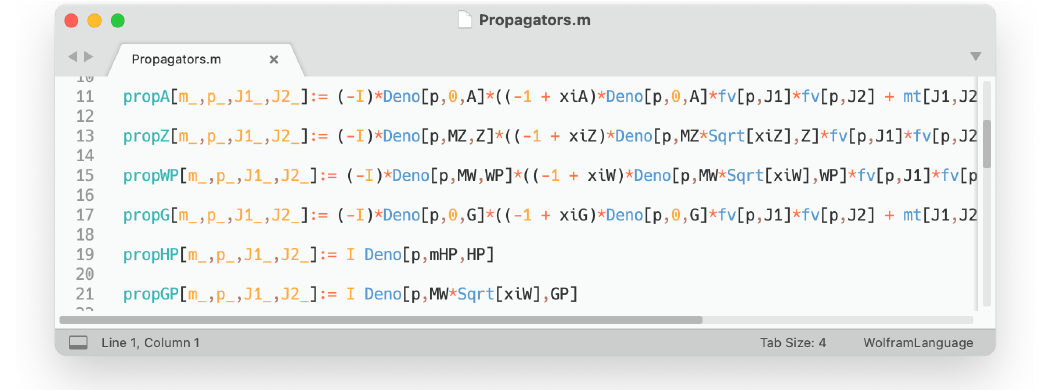
Figure 9 . Excerpt from the CTini.m file, containing the Feynman rules for the counterterms, written in a FeynCalc -readable format.